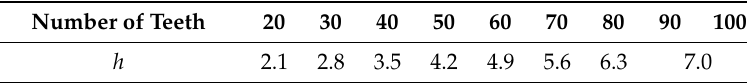
Table 5. Gear parameters used in the finite element